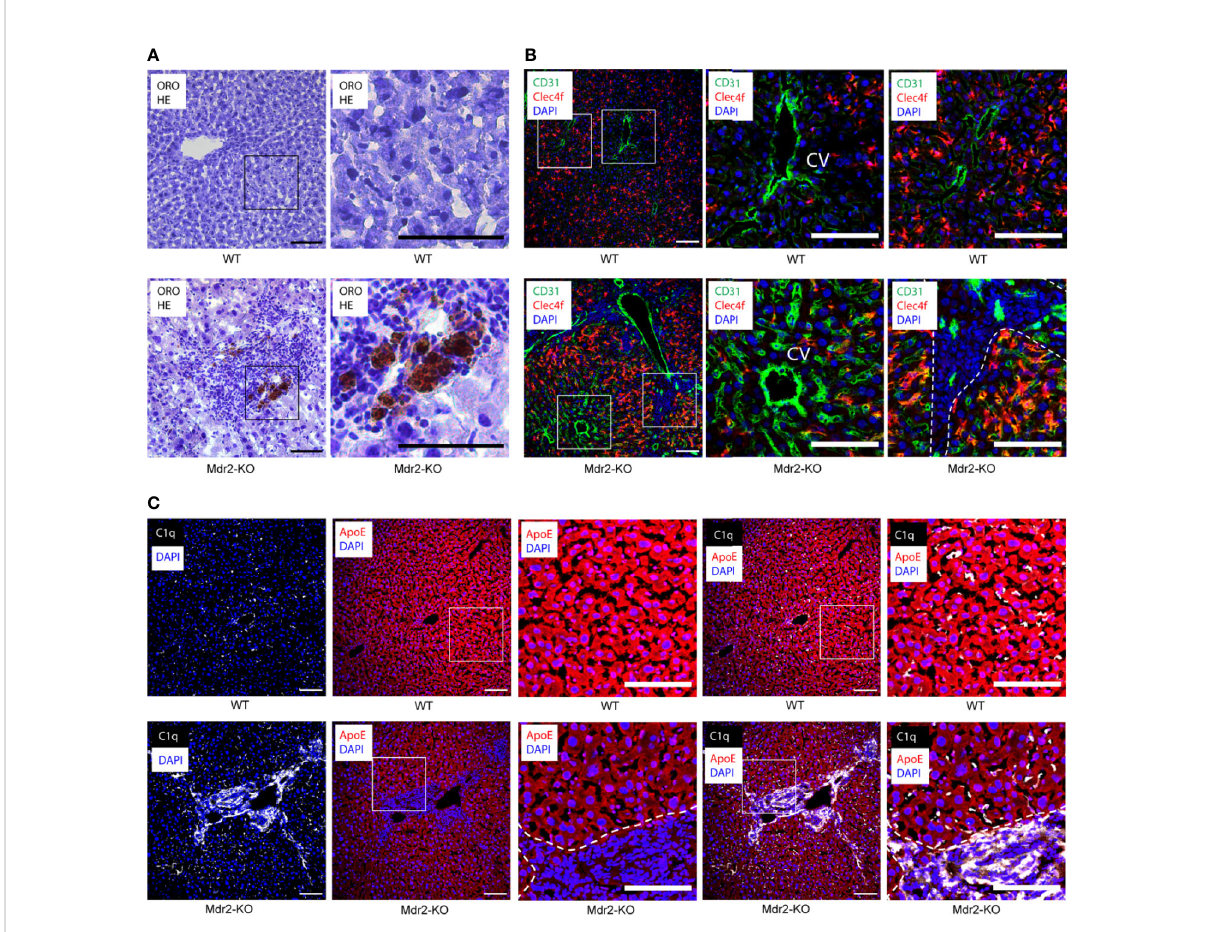
FIGURE 1 Localization of C1q and ApoE proteins in 3 month old WT and Mdr2-KO mouse livers. (A) Liver sections were stained with ORO for lipid (red) and HE for nuclei (blue). In Mdr2-KO immune cell in fi ltrates form primarily in the portal tract areas as well as in the interlobular space. Lipid droplets were observed within the in fi ltration sites. Black squares represent high magni fi cation images below. (B) Sections were stained with CD31 for vascular structures (green), Clec4f for KCs (red) and DAPI for nuclei (blue). CV stands for central vein. Dotted lines demarcate immune cell in fi ltrates in the portal tract areas from surrounding liver tissue. An increase of CD31 expression in Mdr2-KO livers suggests ongoing angiogenesis. White squares represent high magni fi cation images shown separately. (C) Liver sections were stained with ApoE (red), C1q (white) and DAPI for nuclei (blue). White squares represent high magni fi cation images shown separately. Representative images of WT livers (n=6); Mdr2-KO livers (n=6) are shown. Scale bars 100 m m in images of low and high magni fi